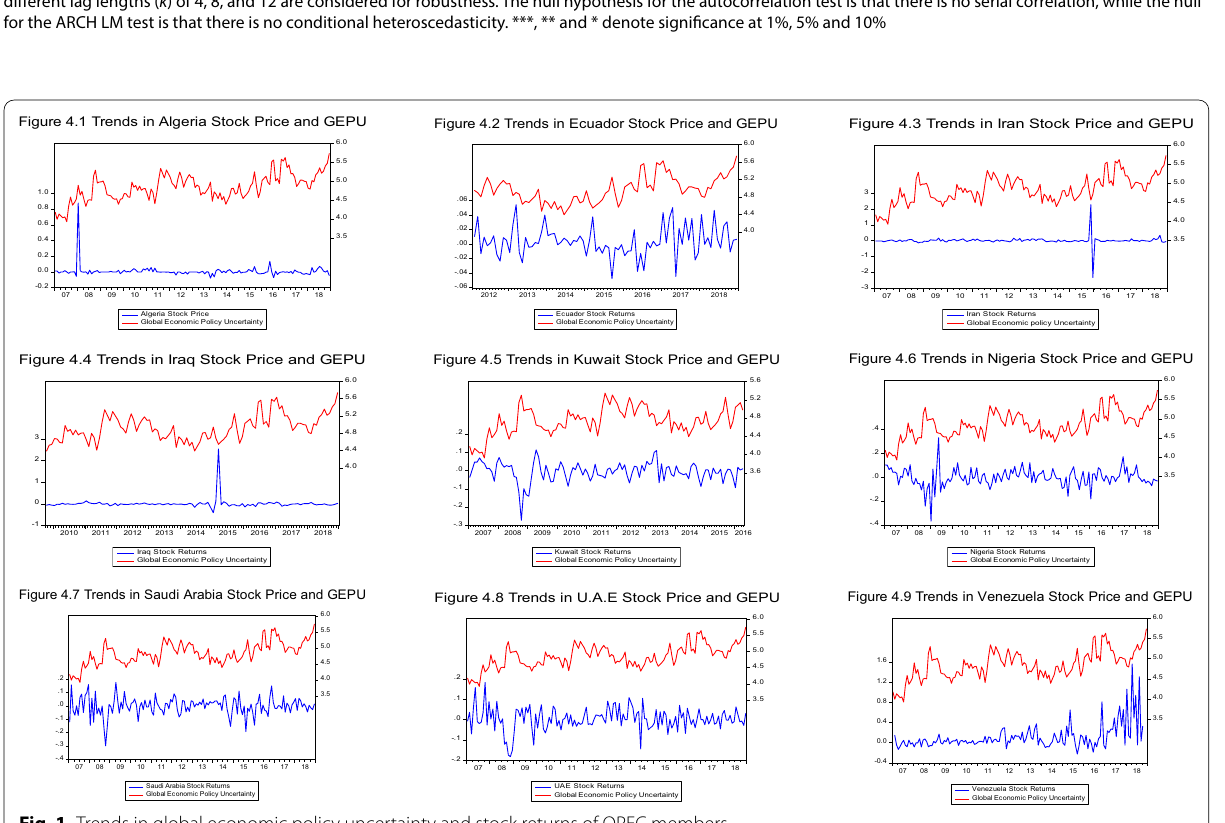
The reported values for the serial correlation are the Ljung-Box Q-statistics, while for the heteroskedasticity test, this study uses the ARCH LM test F-statistics. Three (3) different lag lengths ( k ) of 4, 8, and 12 are considered for robustness. The null hypothesis for the autocorrelation test is that there is no serial correlation, while the null for the ARCH LM test is that there is no conditional heteroscedasticity. ***, ** and * denote significance at 1%, 5% and 10%